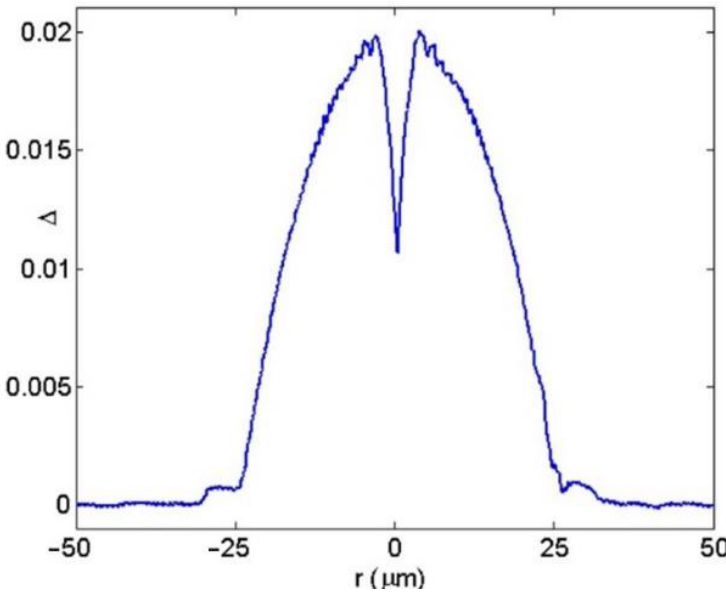
Figure 19. Graded refractive index profile of the tested MMF of Cat. OM2.